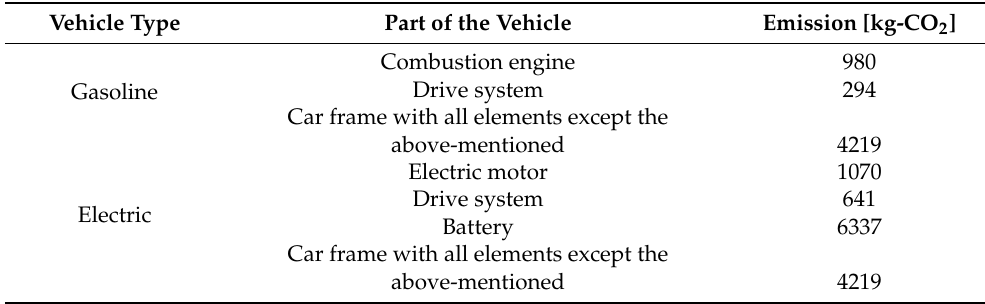
Table 2. Cumulative carbon dioxide emissions in the production phase of both vehicles. Based on, among others,